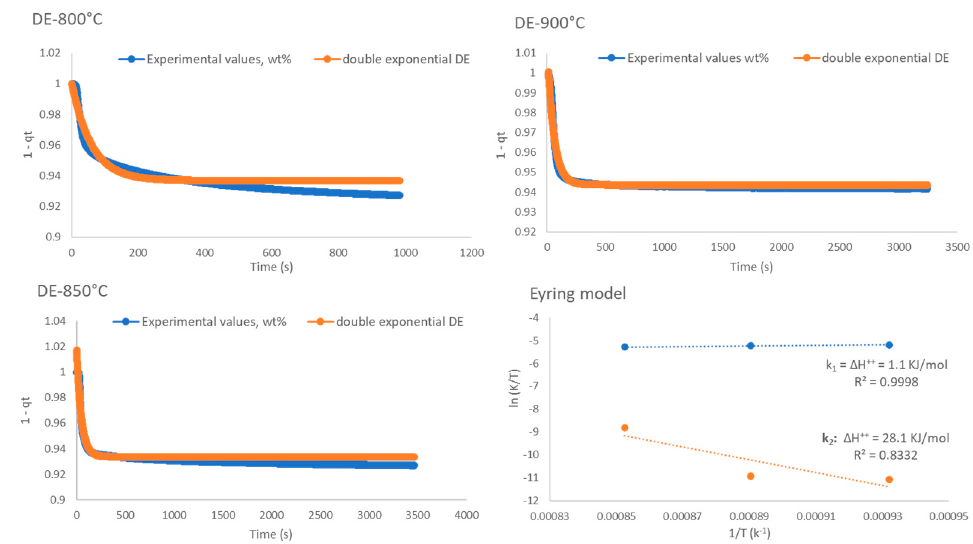
Figure 10. DE and Eyring’s models applied to K-B CO 2 sorption data.